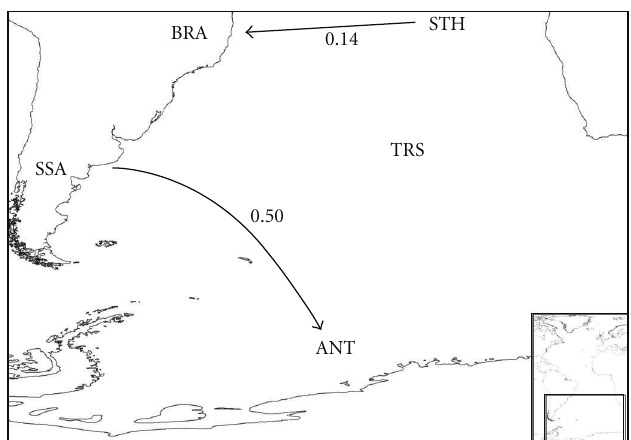
Figure 5: Probable colonization patterns of rissoid fauna in the South Atlantic. The arrows represent the probable main flux direction of faunas, and the associated numbers represent, for each pair of areas, the higher of the two similarity index values computed as described in the methods, abbreviations as in Table 1.